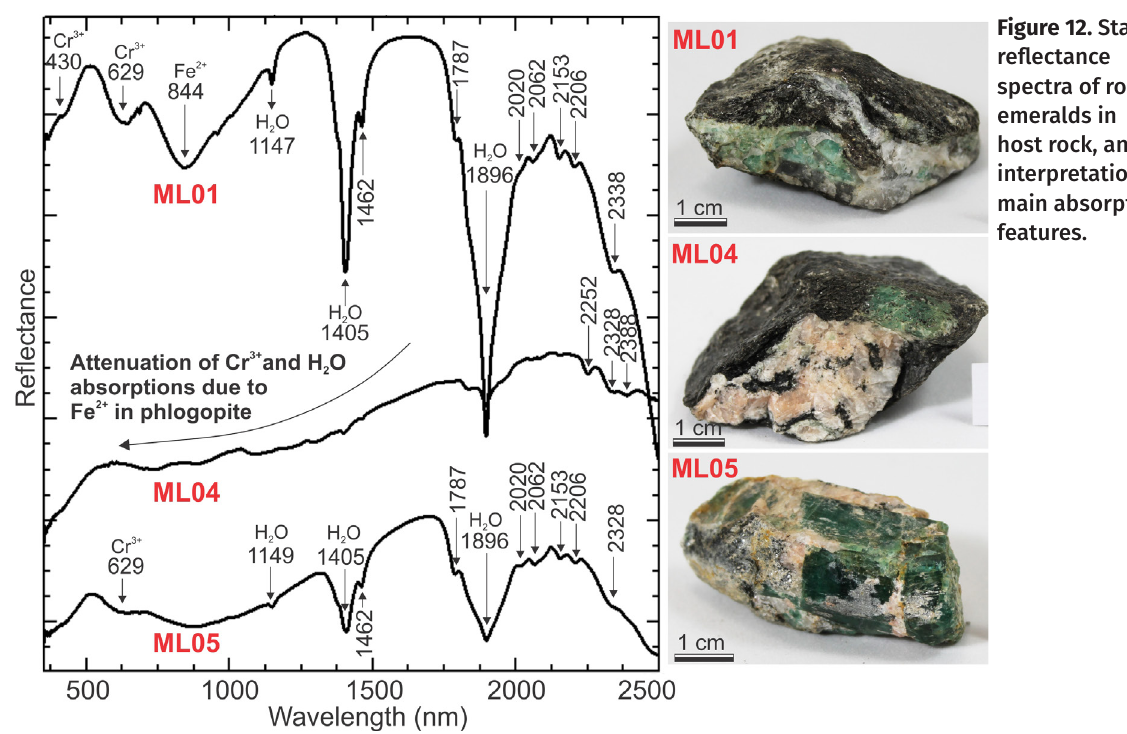
Figure 12. Stacked reflectance spectra of rough emeralds in host rock, and interpretation of main absorption